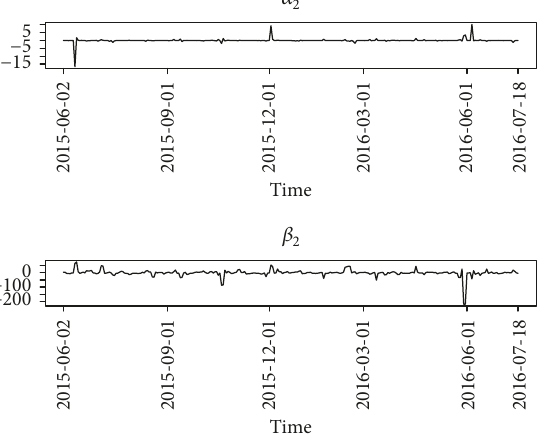
since the error of the martingale is the smallest. But the forecasts of model D are very similar to the martingale and has the best performance among the four dynamic models. To sum up, model D is the most proper model to characterize the TAIEX closing prices but we still need to examine and model the coefficients to increase its forecasting ability.